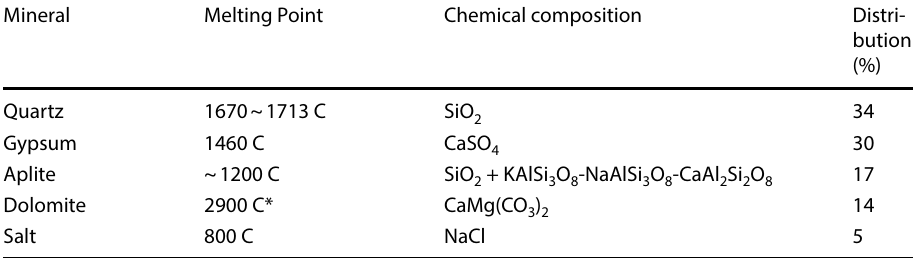
Mineral Melting Point Chemical